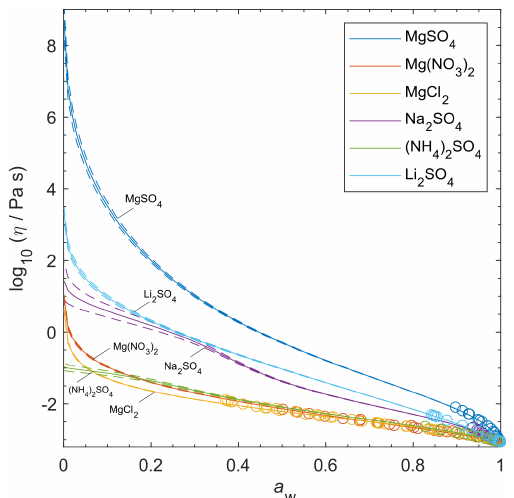
Figure 10. AIOMFAC-VISC-predicted viscosity for selected bi- nary aqueous electrolyte solutions at 298.15 K. Model sensitivity (dashed curves) shows the impact of a ± 2% variability in deter- mined aerosol water content at stated water activity, a w . Bulk mea- surements are shown as open circles, with colors matching the pre- diction curves for each